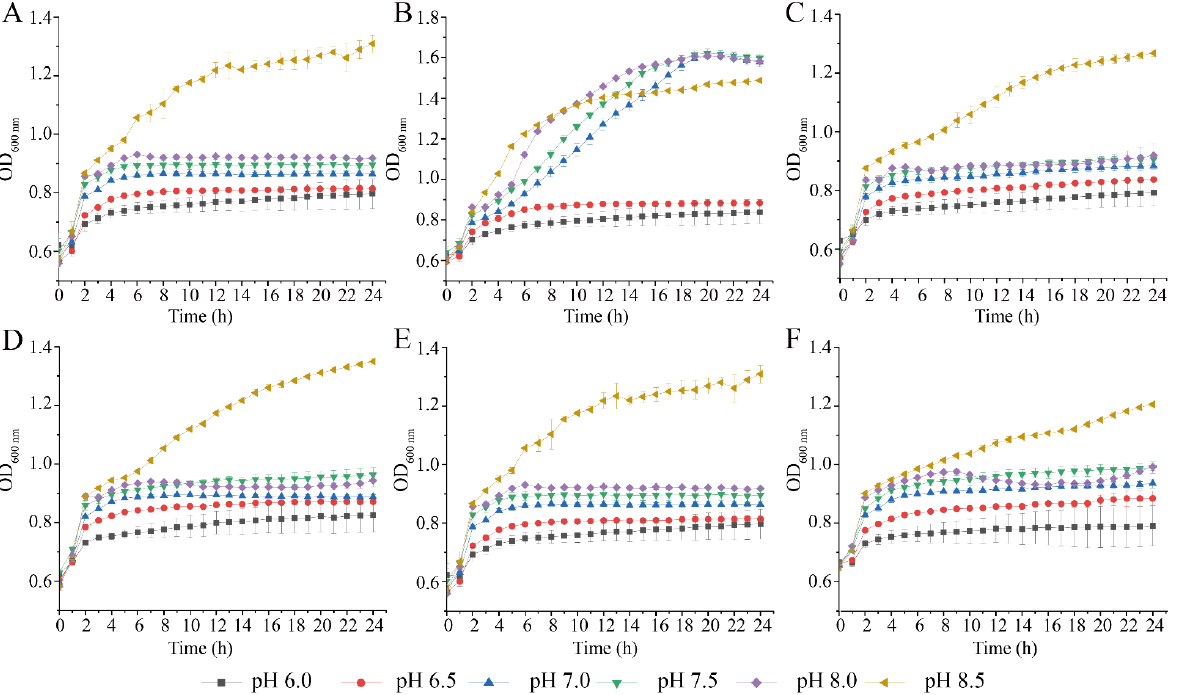
Figure 1. Survival of six V. parahaemolyticus isolates in different pH conditions. The isolates were incubated in TSB medium (3% NaCl) at 37 °C. ( A – F ): V. parahaemolyticus L7-7, N1-22, N3-33, N4-46, N8-42, and Q8-15, respectively.